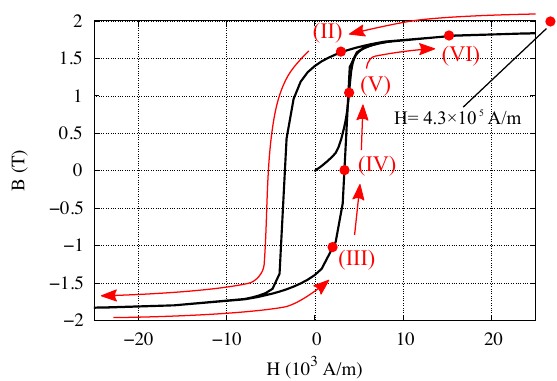
Figure 2. Measured hysteresis curve of the Fe/Si multilayer. Red circles (I)–(VI) indicate the conditions chosen for the polarized OSS and GISANS measurements. The applied field was varied along the red arrows.